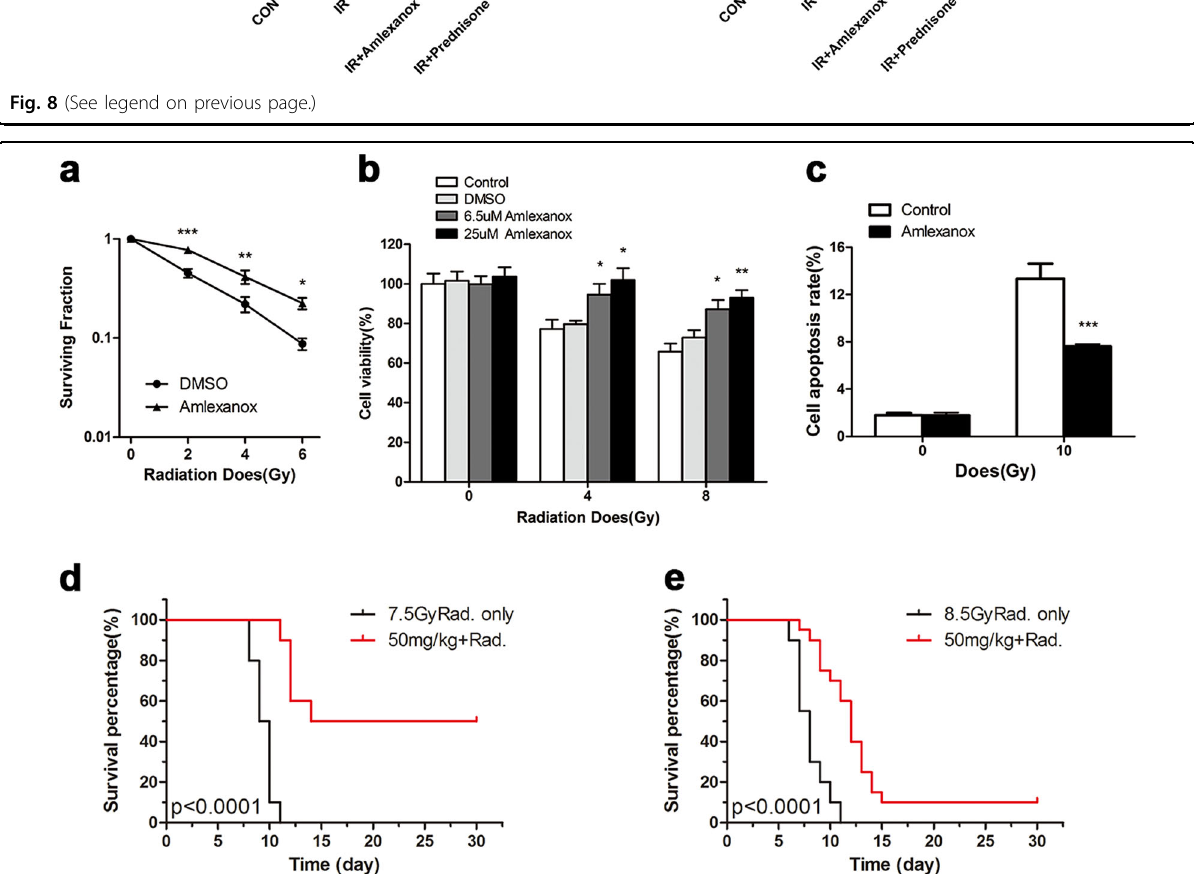
Fig. 9 The TBK1 inhibitor Amlexanox protected cells and mice against lethal radiation damage. After 2, 4, 6, or 8 Gy single-dose irradiation, cell survival was determined in the radiation- and Amlexanox-treated groups via colony formation ( a ) and CCK-8 ( b ) assays. Cell apoptosis was measured by fl ow cytometry 24 h after 10 Gy irradiation ( c ). For in vivo study, BALB/c mice with/without Amlexanox treatment were exposed to 7 or 8.5 Gy irradiation, and animal survival was monitored for up to 30 days after irradiation ( d , e ). * P < 0.05, ** P < 0.01, and *** P < 0.001 vs. nonirradiated